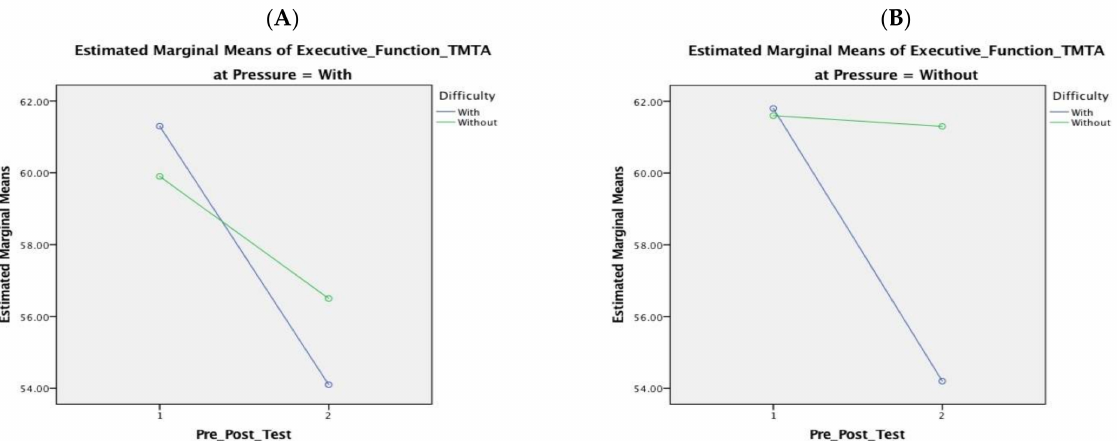
Figure 12. The graph of three-factor interaction in TMT-A. Figure ( A ) shows the interaction of pre/post-test * difficulty with pressure condition; Figure ( B ) shows the interaction of pre/post-test * difficulty without pressure condition. Note: pre/post-test (the horizontal axis), pre-test = 1, and post-test =